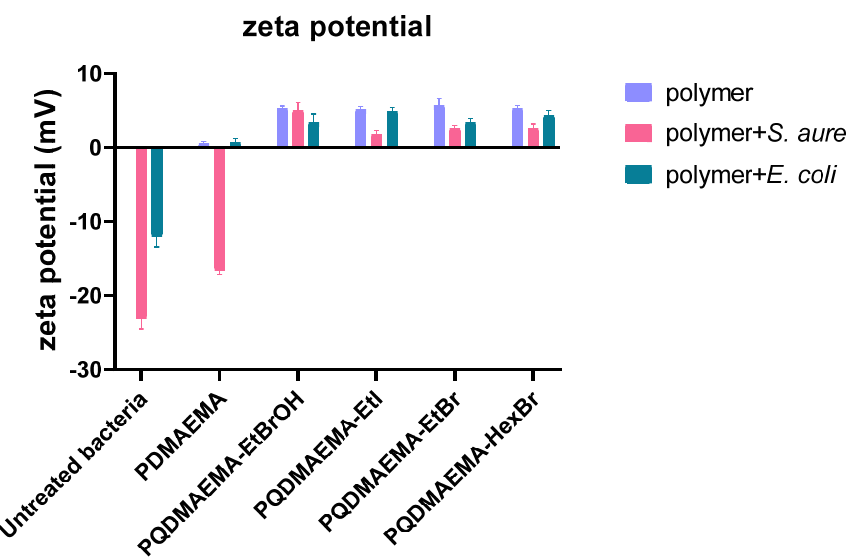
Figure 6. Zeta potential values for 5 mg/mL polymer solutions in LB (blue bars), and E. coli (green bars) and S. aureus (pink bars) suspensions incubated with 5 mg/mL cationic polymers in LB (blue bars).